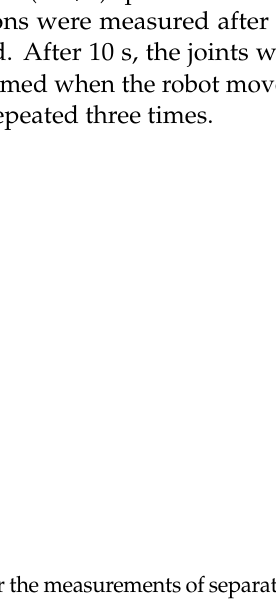
Figure 6. Flowchart of the vibration measurement process. Signals from three accelerometers were recorded continuously during robot movement between the endpoints of the trajectory. Later acquired data were processed offline (Figure 7), defining transient processes due to robot stops at the trajectory endpoints.